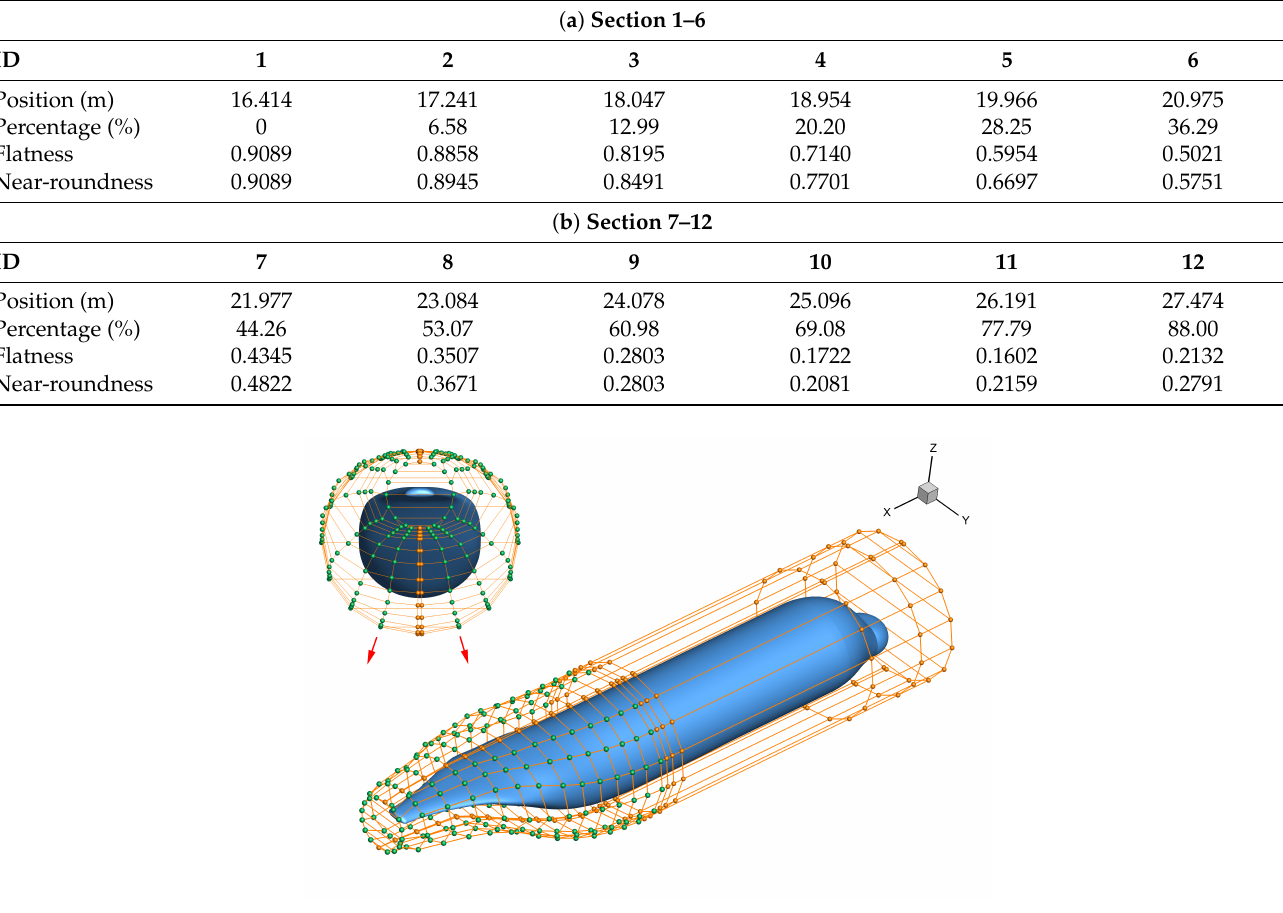
Figure 10. The military transport aircraft FFD frame.